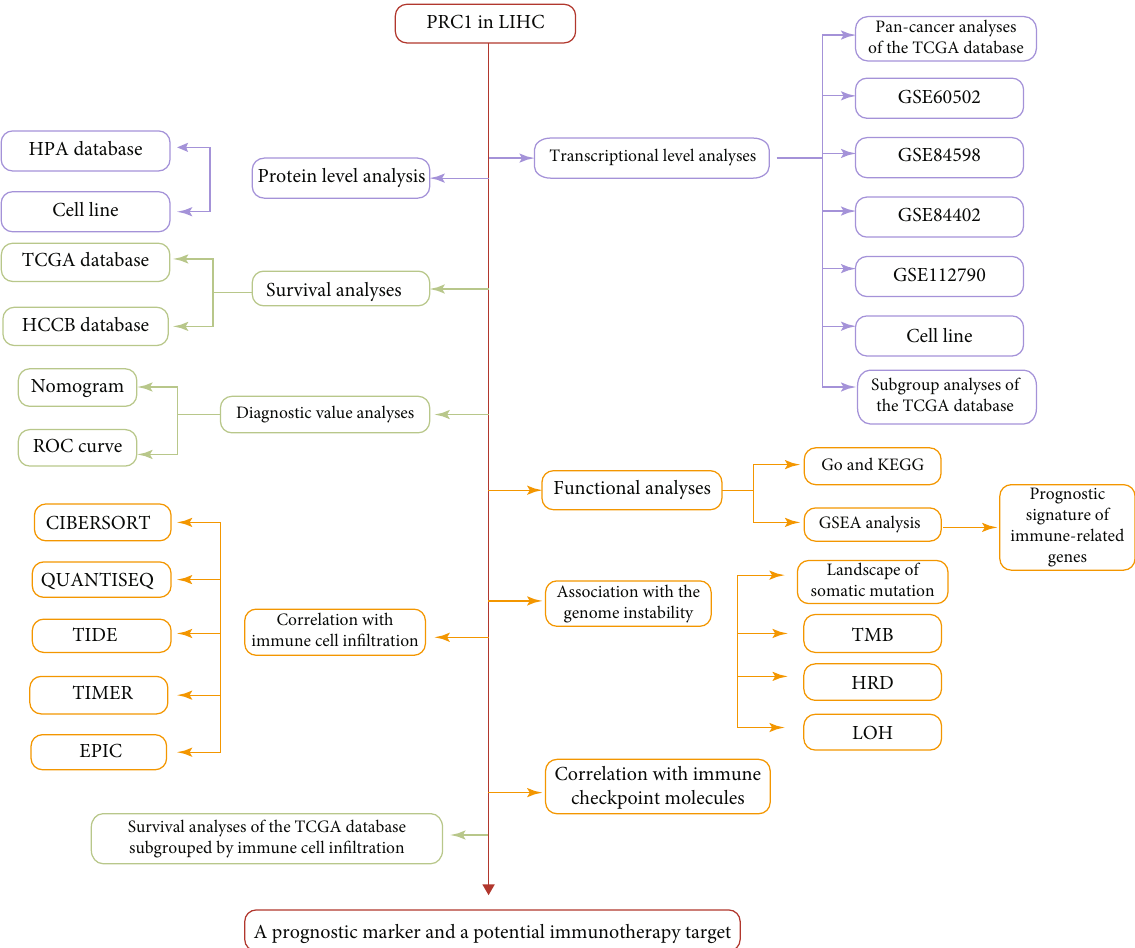
Figure 1: Study design and method implementation in this